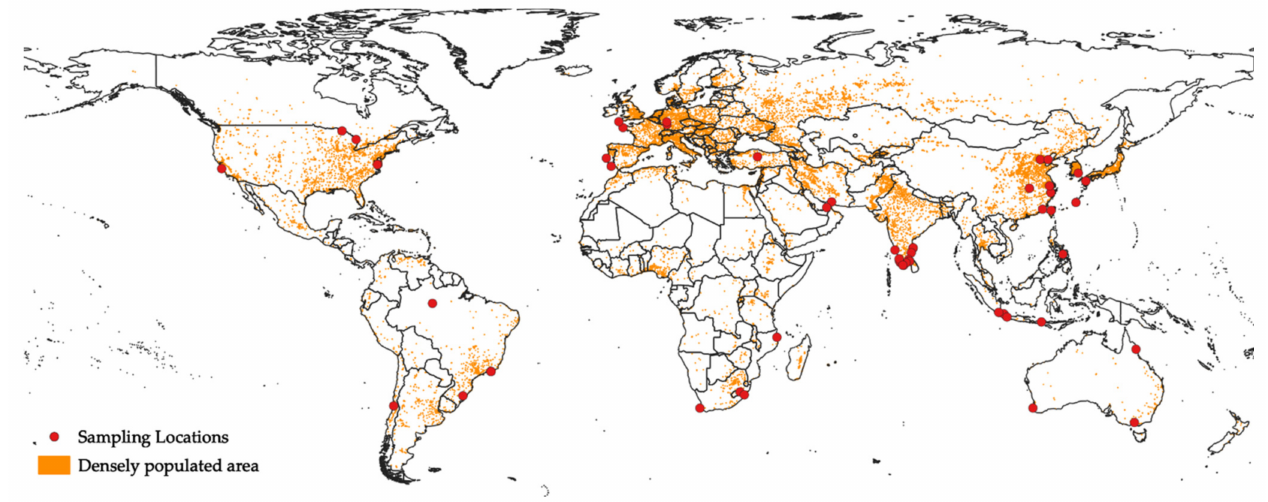
Figure 1. Distribution of the sampling sites of studies that linked microplastic pollution to an- thropogenic activities. Densely populated area data were retrieved from Natural Earth (http: //www.naturalearthdata.com (accessed on 20 December 2021) [43]. The Antarctica region was excluded as it is an area with limited human activities. Coordinate reference system: WGS 84, EPSG: